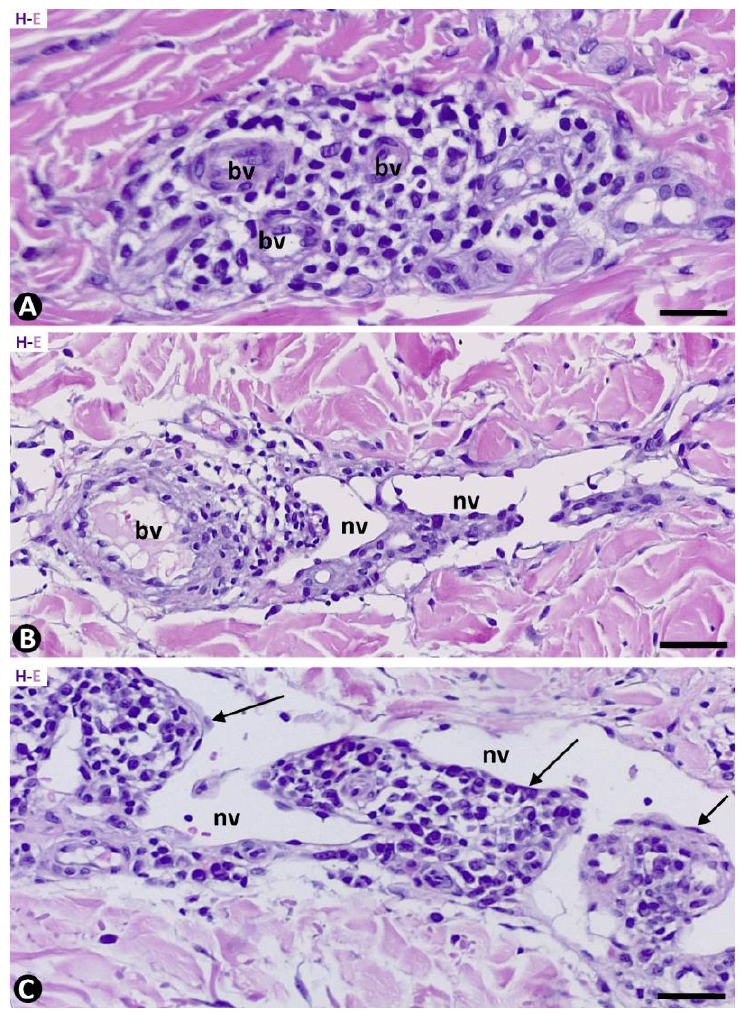
Figure 1. Inflammatory infiltrate ( A ) and associated newly formed vessels (( B , C ), nv) around blood vessels (( A – C ), bv) are observed in the patch stage of KS. Note in B and C the protrusion of the blood vessels and the perivascular inflammatory infiltrate in the lumen of the neovessels, giving rise to the promontory sign (( C ), arrows). Hematoxylin and eosin. Bar: ( A ): 30 µ m, ( B ): 50 µ m, ( C ): 40 µ